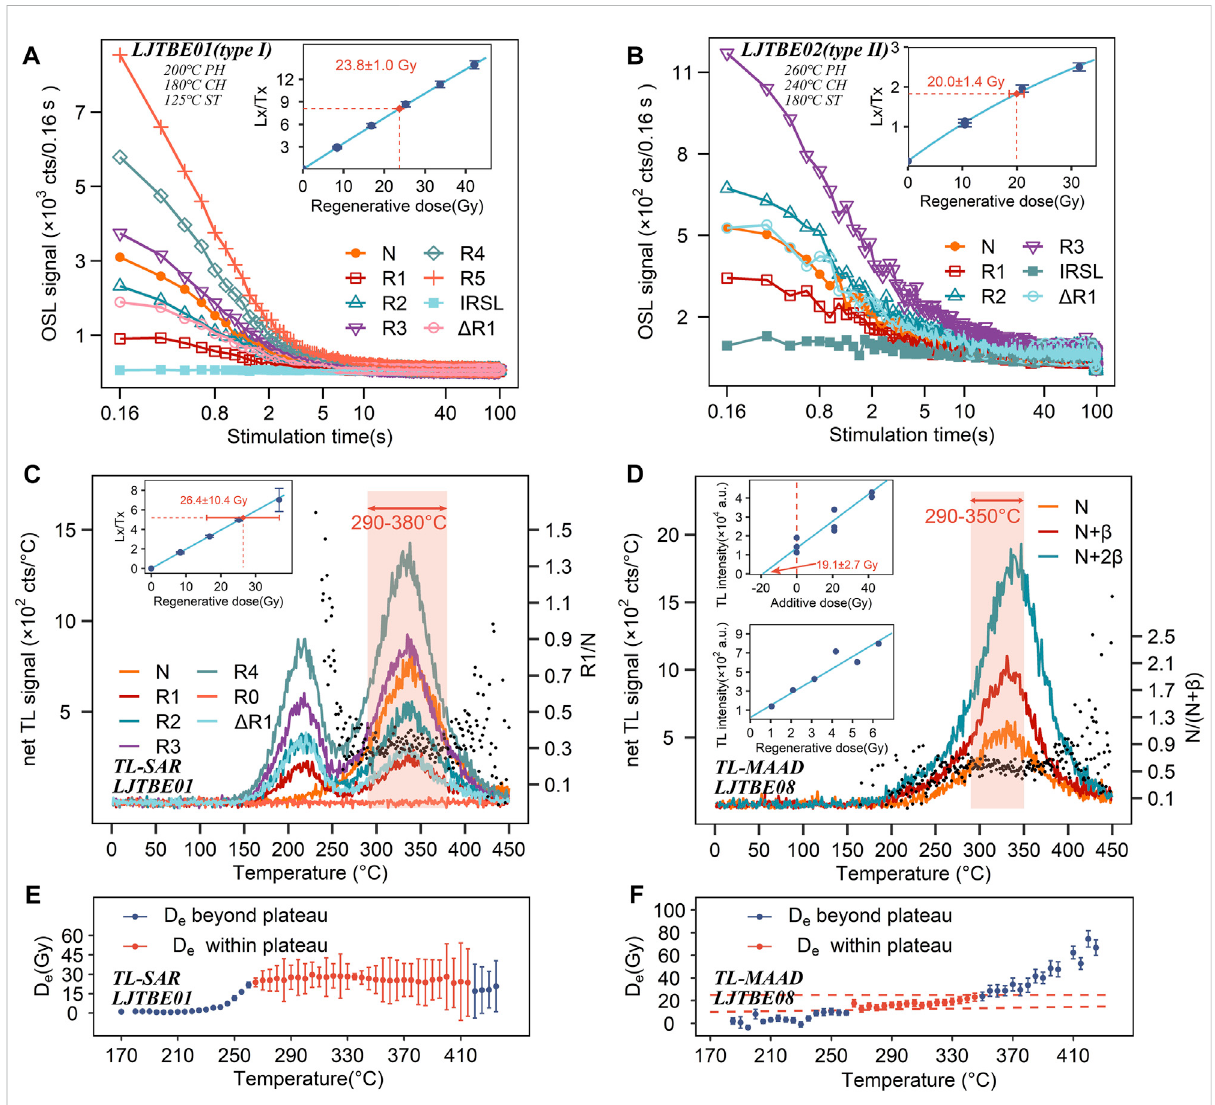
feldspar.Thepreheat(PH)andcut-heat(CH)temperaturesfortypeIsampleswere200and180 ° C,respectively,andthestimulationtemperature(ST) was 125 ° C. (B) The natural (N) and regenerative doses (R1-R3, Δ R1) OSL decay curves and their DRCs for a representative type II sample ( LJTBE02 ). Similarly, the OSL signal of this sample does not contain a feldspar signal. Unlike the type I samples, the PH and CH temperatures for the type II samples were 260 and 240 ° C, respectively, and the stimulation temperature was 180 ° C. (C) The natural (N) and regenerative (R1-R4, R0, Δ R1) TL curves after background subtraction of a representative sample ( LJTBE01 ) for TL-SAR dating procedures, where R0 means the zero dose point and Δ R1 means the repeated dose equals R1. The right axis is the value of R1/N, used to fi nd the heating plateau. The inset shows the corresponding DRC. Combining the results of the heating plateau and D e plateau, the fi nal TL integration interval of 290 – 380 ° C was used to calculate the D e value. (D) The natural (N) and additive doses (N+ β , N+2 β ) TL curves after background subtraction of a typical sample ( LJTBE08 ) for TL-MAAD dating procedures. The heating plateau can be inferred from the N/(N+ β ) marked with black dots. Each dose utilizes three aliquots to obtain the TL signal. The fi rstinsetshows theDRCcurve, andthesecond insetindicatesthesecond TL(the fi rstnaturalTLwas bleachedbyheat)DRC